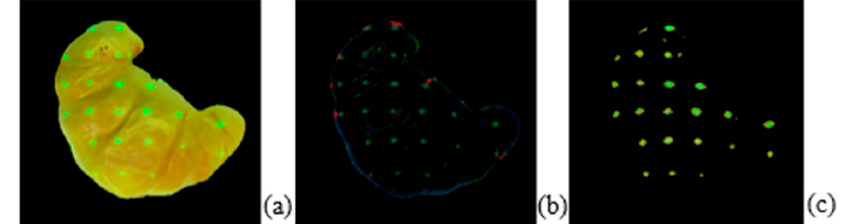
Figure 11. Original croissant picture ( a ), croissant picture with just the border ( b ), and croissant picture after the luminance mask is completely applied ( c ). The green dots in the image ( c ) are brighter than in image ( b ) due to the luminance mask; the luminance mask makes the dots easier to detect in the post-processing step.